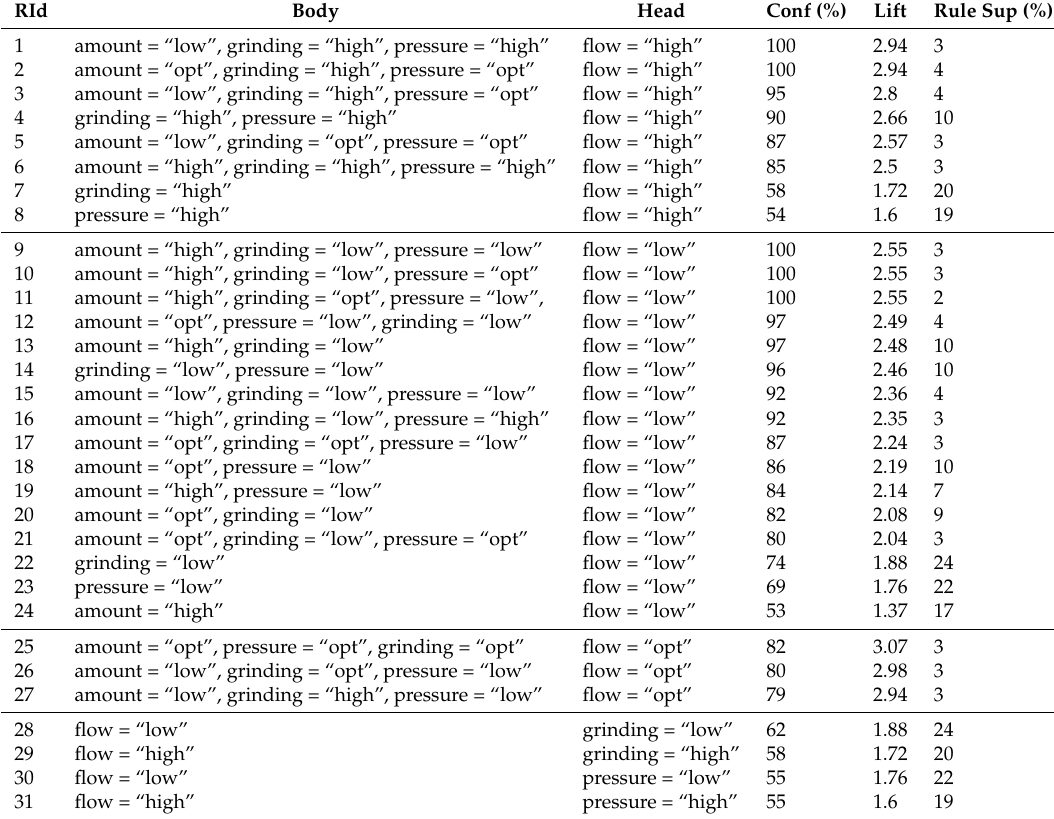
Table 7. Association rules involving the flow rate